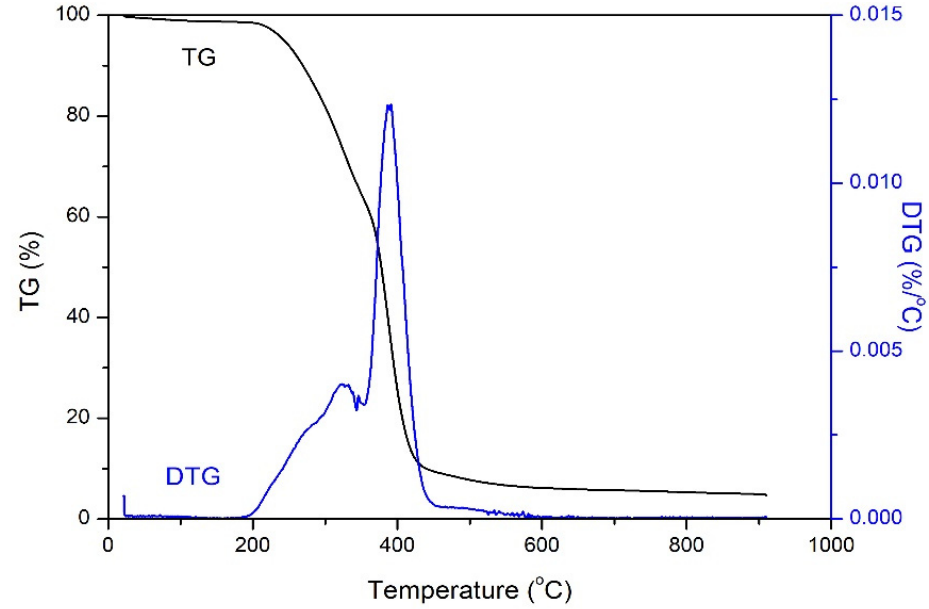
Figure 4. TGA analysis of polyurea A.